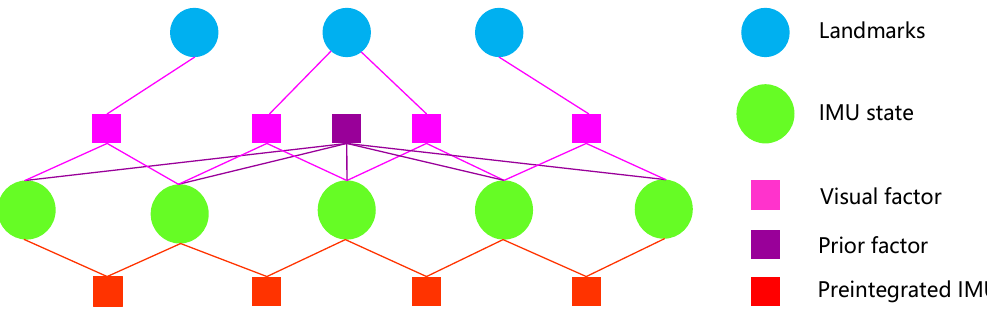
Figure 4. Optimization of a factor graph in the VIO system. Pink squares represent visual factors, purple squares represent prior factors, red squares represent IMU preintegration factors, blue nodes represent visual feature state variables to be optimized, and green nodes represent IMU body state variables to be